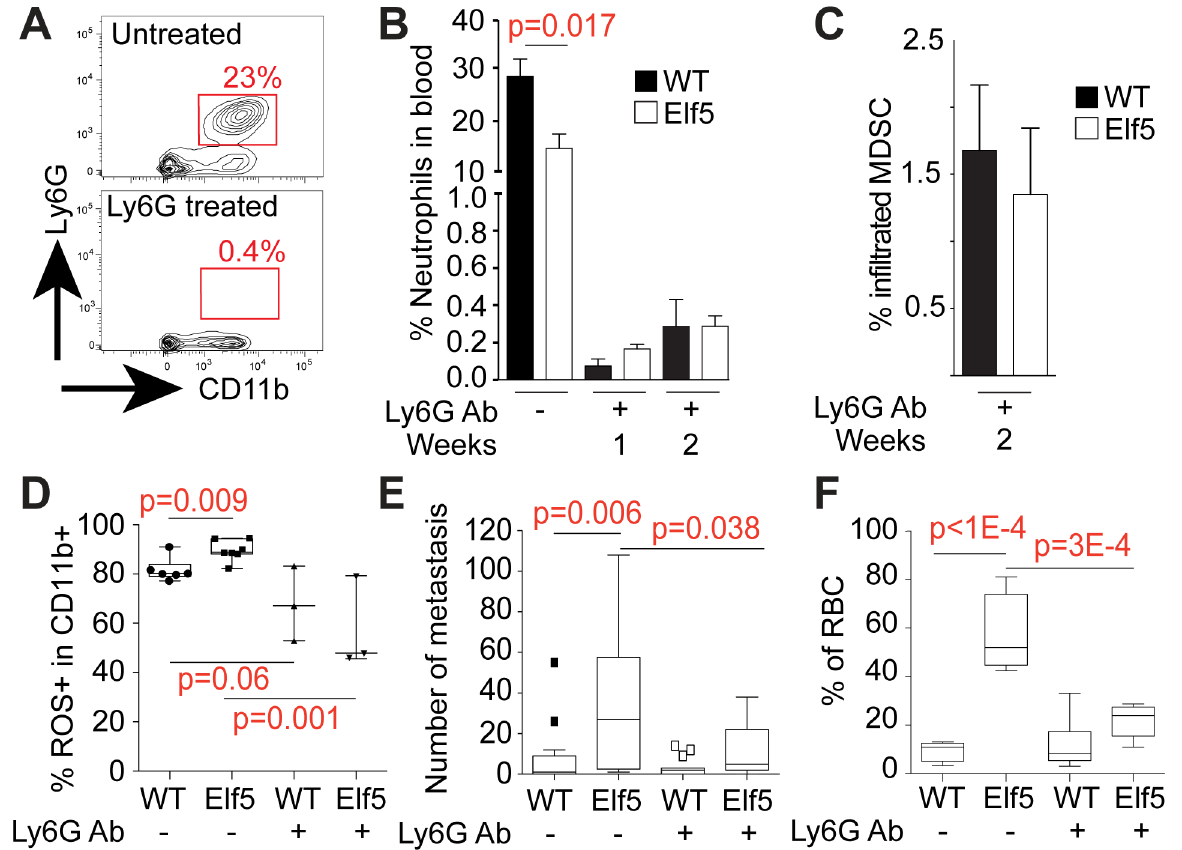
Fig 7. Effect of depletion of MDSC on ELF5-driven lung metastasis and vascular permeability. Panel A , representative plot of the depletion of Ly6G + cells by treatment for 2 wk with the Ly6G antibody. Panel B , Time course for the depletion of neutrophils by treatment with the Ly6G antibody. Panel C , Effects of Ly6G antibody treatment on tumor infiltrated MDSC in mice of the indicated genotypes. Panel D , effect of Ly6G treatment on total ROS production in the CD11b+ myeloid population measured by FACS. Panel E , effect of Ly6G treatment on lung metastases. Panel F , effects of treatment with the Ly6G antibody on tumor vasculature leakiness. RBC: red blood cells. Raw data for panels B and C can be found at S4 Data.